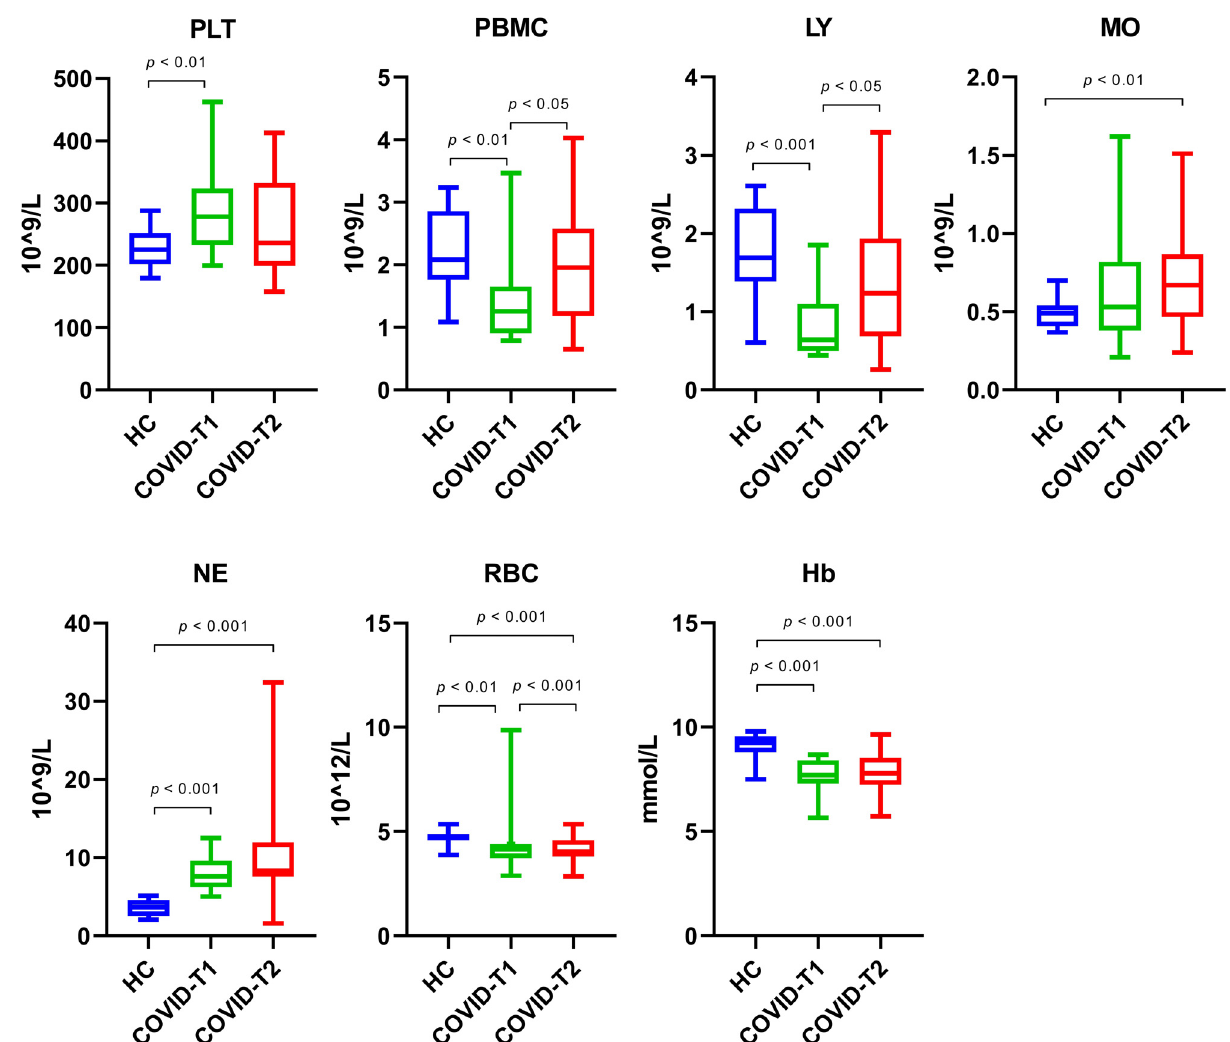
Figure 4. Whole blood cell counts for platelets (PLT), PBMC, lymphocytes (LY), monocytes (MO), neutrophils (NE), red blood cells (RBC), and Hb levels for the healthy control (HC), COVID-T1, and COVID-T2 groups.